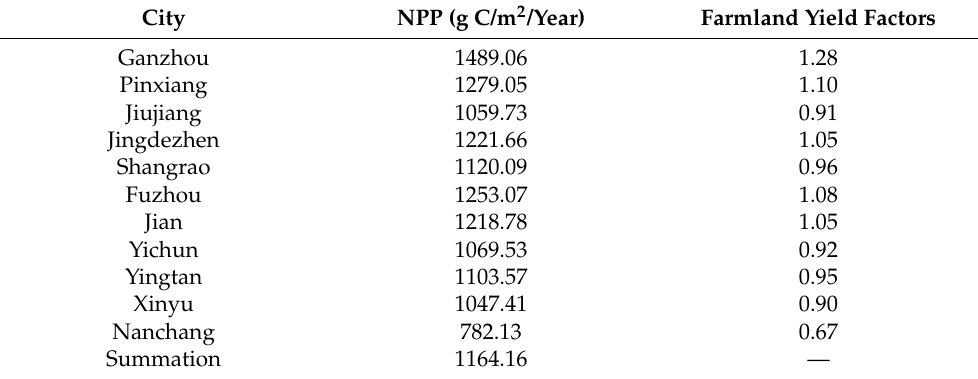
Table 1. Farmland yield factors in various cities of Jiangxi